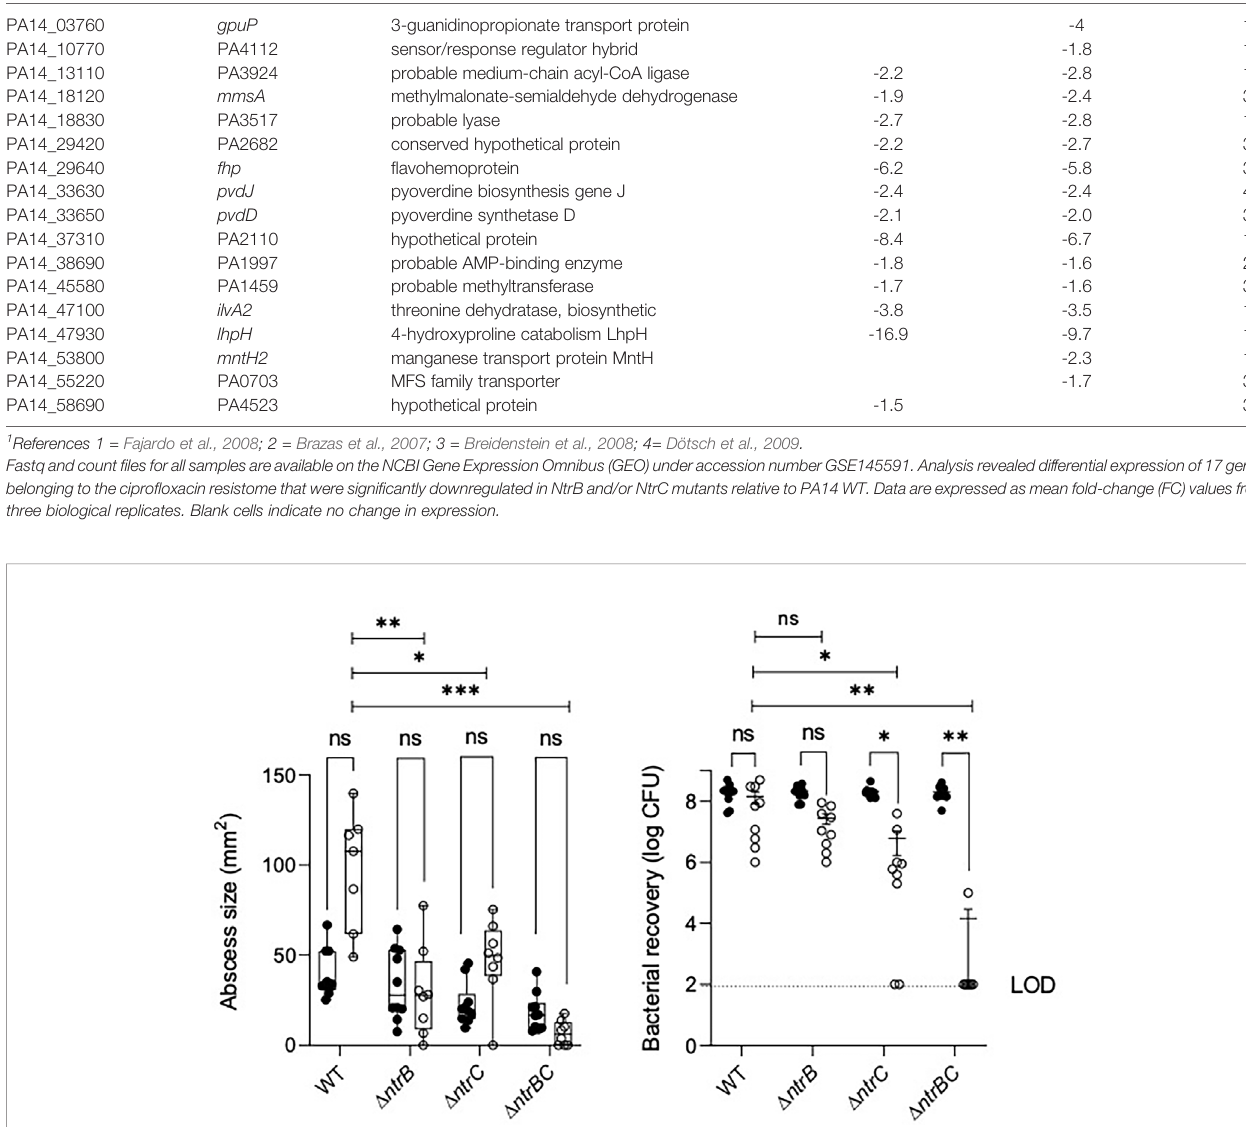
TABLE 2 | Genes in the cipro fl oxacin resistome were downregulated in P. aeruginosa NtrBC mutants. PA14 ID